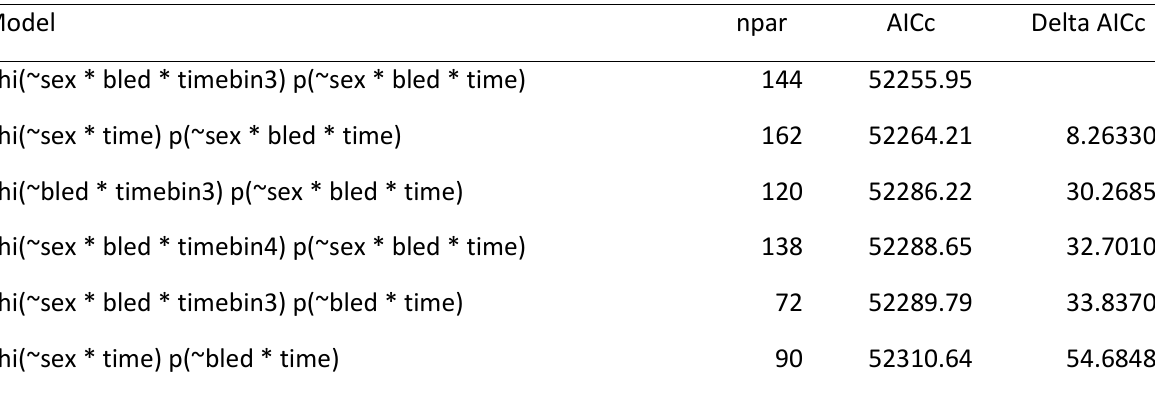
Table 21. Model statistics for the top 6 out of 70 models fit to the capture recapture data for horseshoe crabs tagged in the coastal Delaware and Virginia geographic area between 1999 and 2017. Model names include group and time effects for apparent survival (Phi) and capture probability (p); npar=number of parameters; AICc=corrected Akaike Information Criteria; Delta AICc=0 indicates the best fitting model.